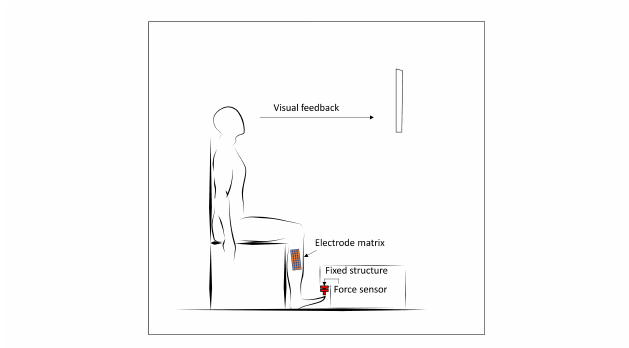
Figure 2. A visual representation of the experimental setup for the tibialis anterior force-tracking